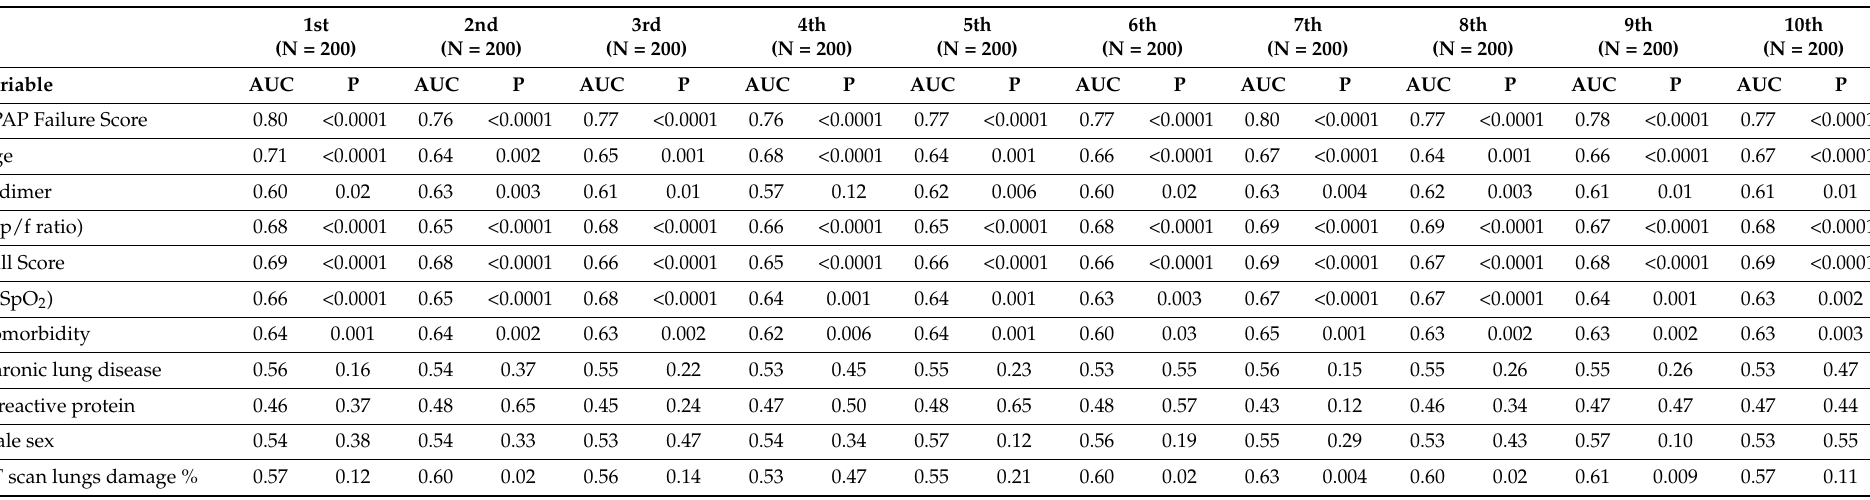
Table 6. Diagnostic ability of the CPAP Failure Score compared with other relevant clinical factors for the potential failure of CPAP approach: 10-fold internal validation of the model in the pre-IPTW